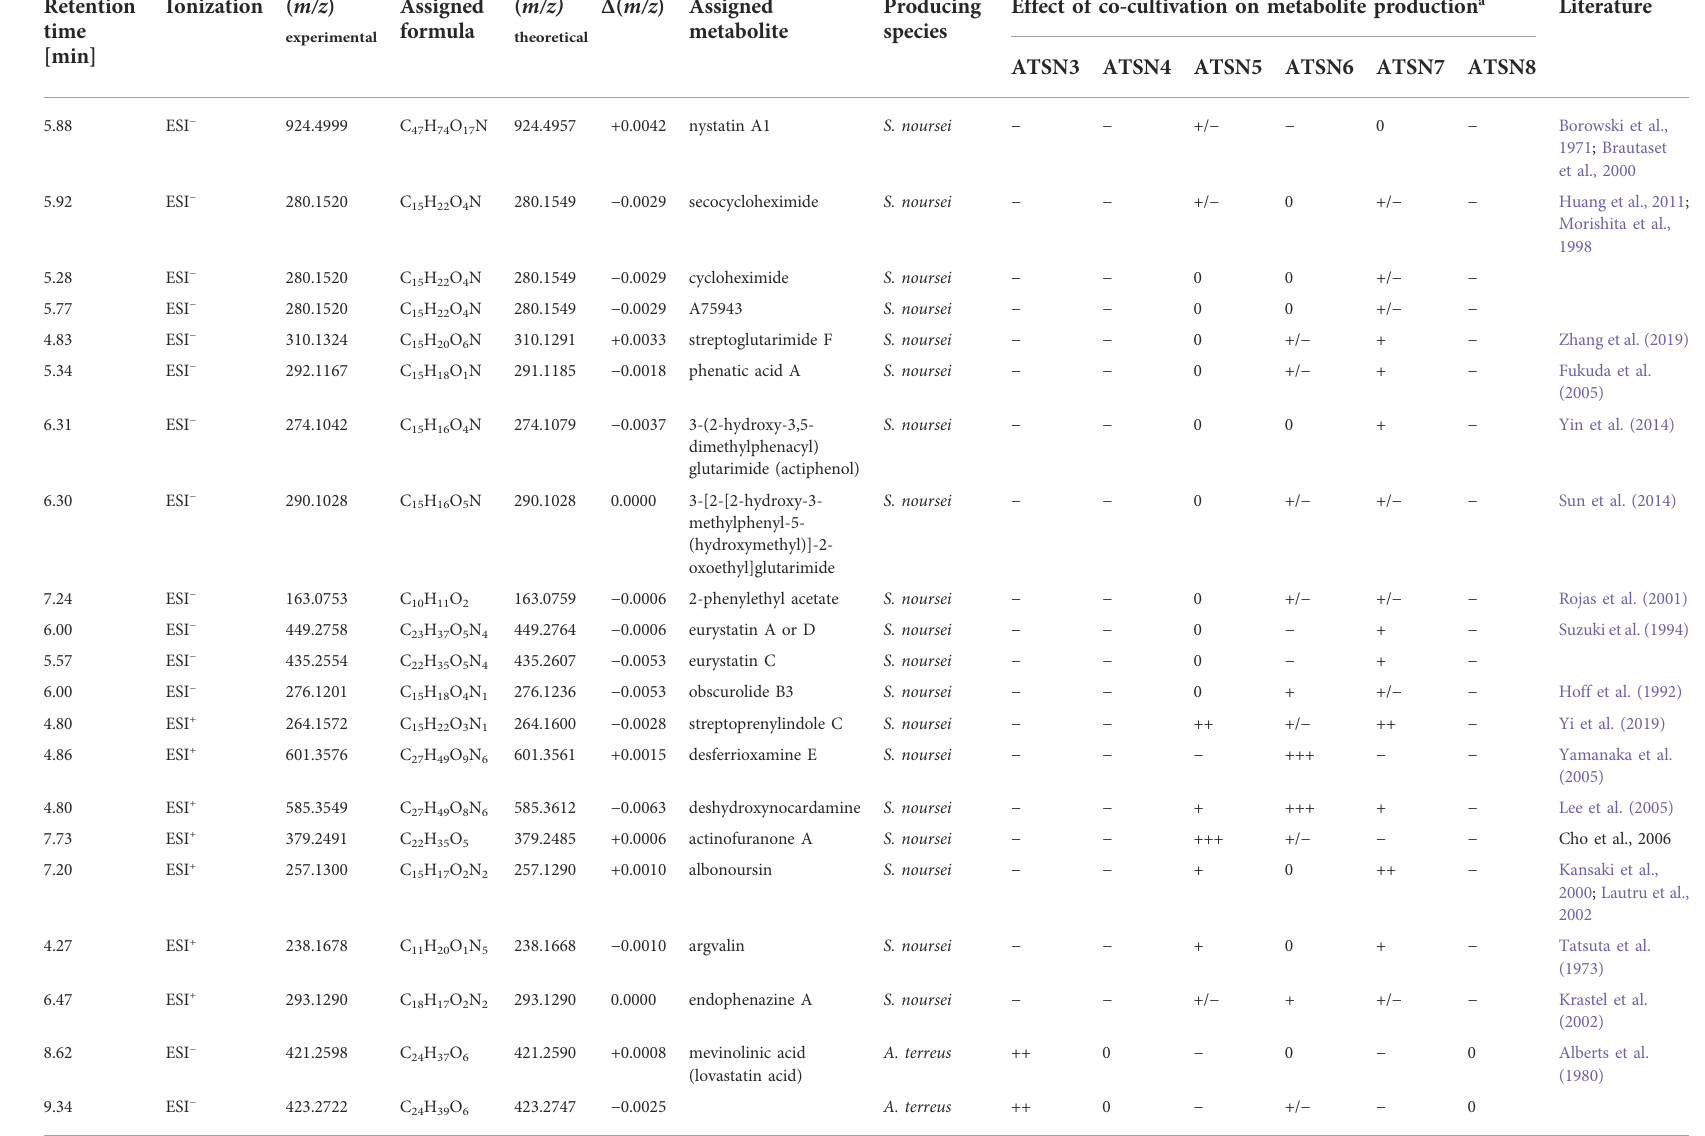
TABLE 2 Secondary metabolites identi fi ed over the course of the